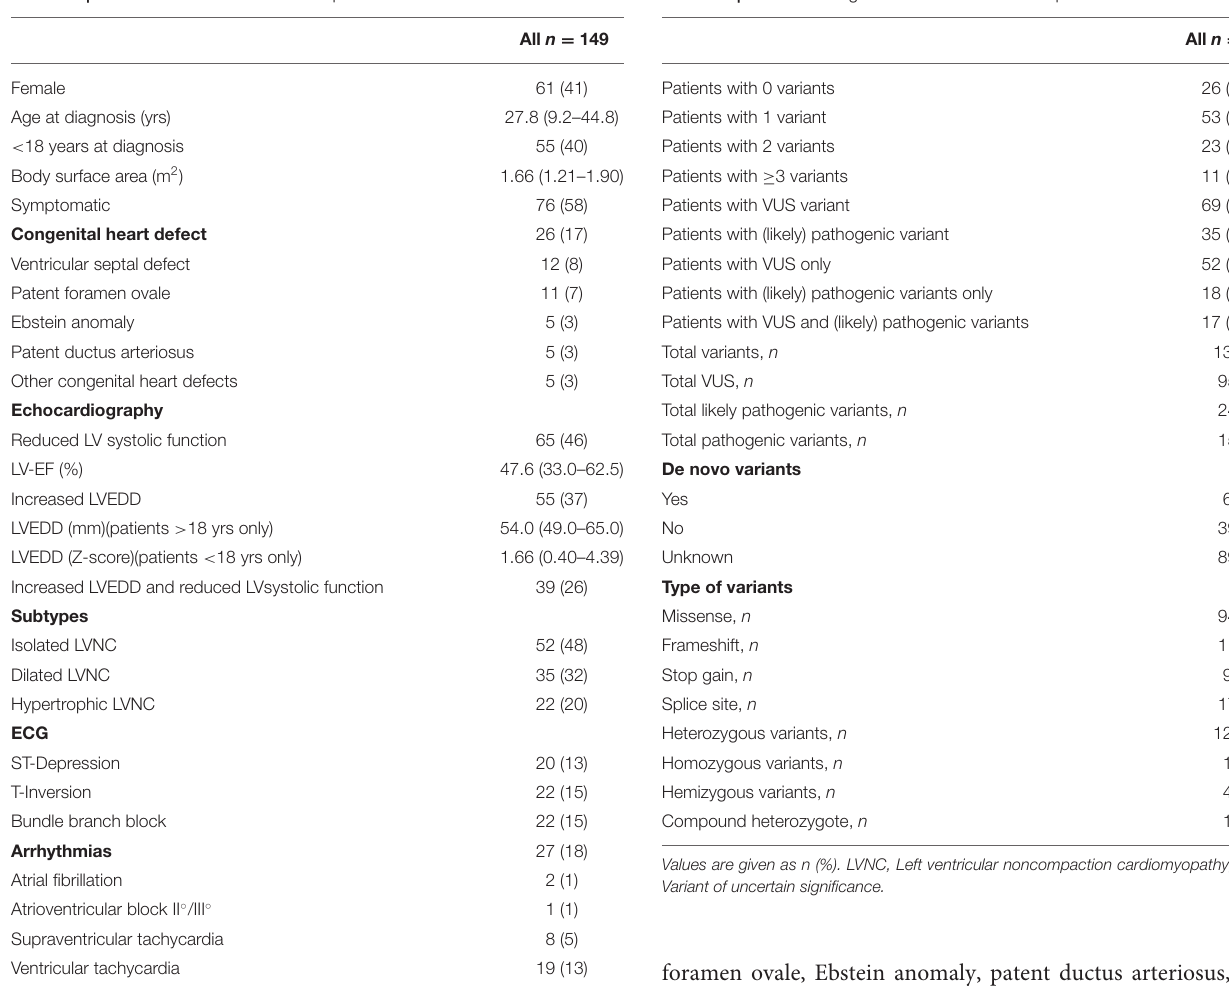
TABLE 1 | Clinical characteristics of LVNC patients. TABLE 2 | Genetic findings in unrelated LVNC index